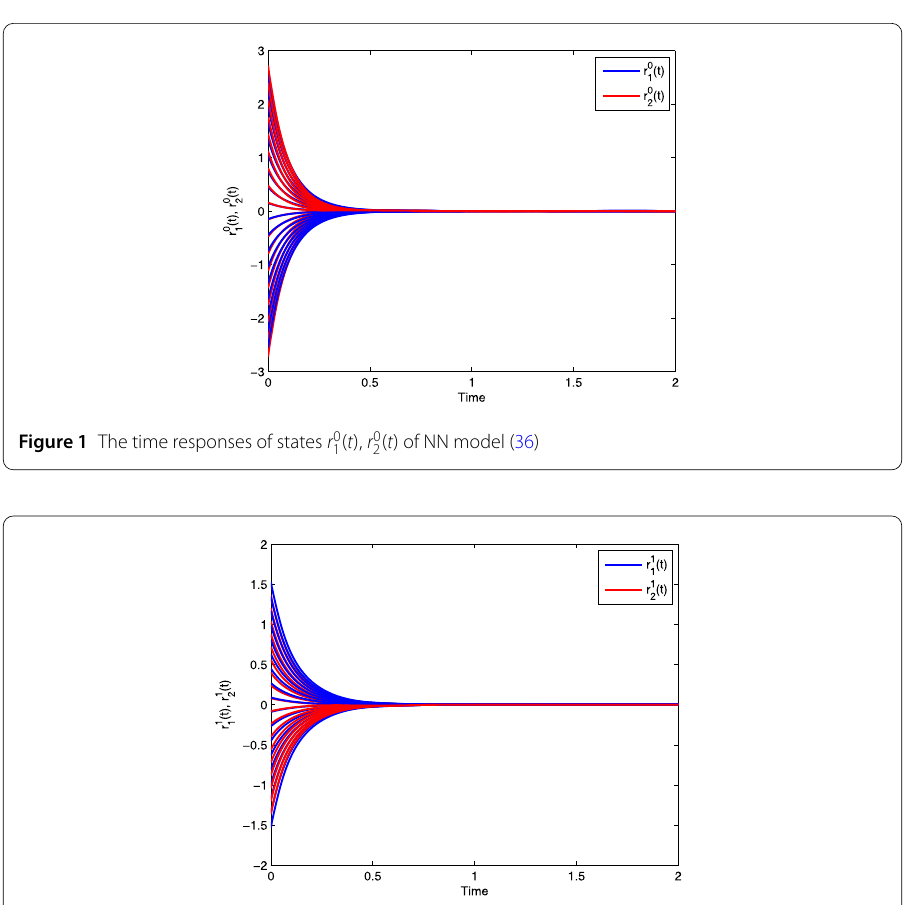
and the positive diagonal matrices C = diag { 2.5673,2.5579,2.5666,2.5626,2.5665,2.5627, 2.5674,2.5580 }